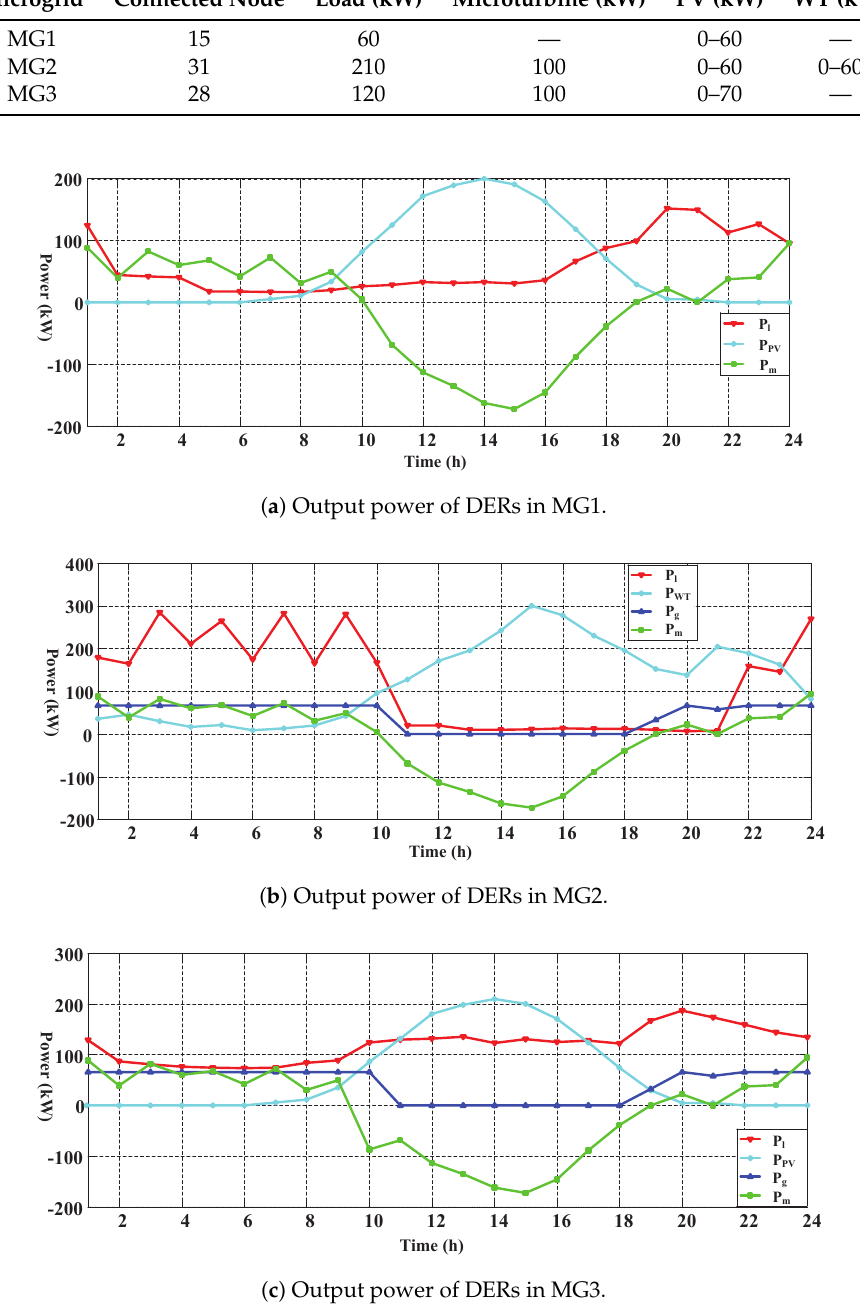
Figure 6. Results of stochastic scheduling of 3